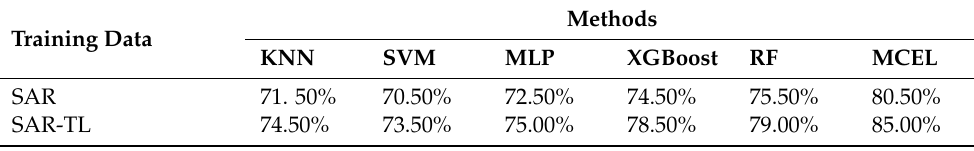
Table 4. Ship classification accuracy of each classification method on the SAR test set.